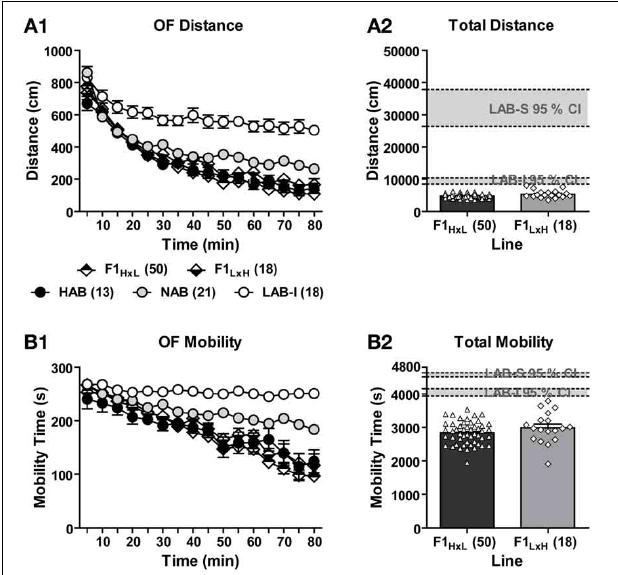
FIGURE 6 | Locomotor activity in F1 H × L vs. F1 L × H mice. In an 80-min OF test, F1 hybrids originating from HAB × LAB (F1 H × L ) and LAB × HAB (F1 L × H ) breeding exhibited the same level of (A1) distance traveled and (B1) mobility time that was much lower than the level of NAB and LAB-I mice. Concerning the (A2) total distance traveled and (B2) total mobility time, no F1 hybrid fell in the 95% confidence intervals (CI; gray block) of LAB-I- or LAB-S-like phenotypes in locomotion and mobility.